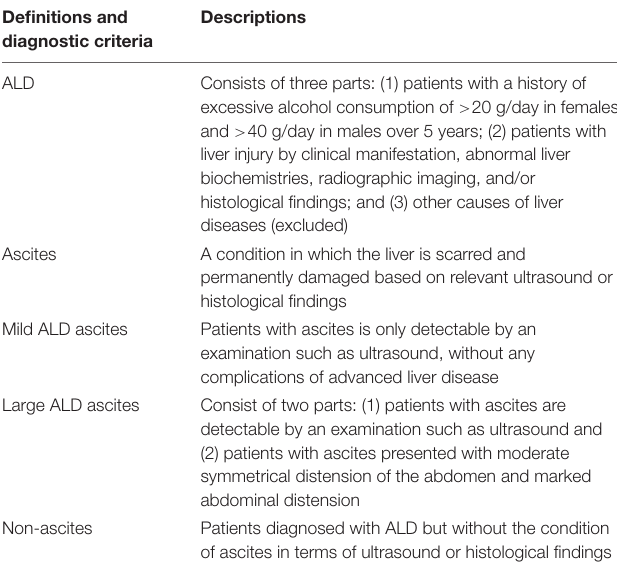
TABLE 1 | Diagnostic criteria and definitions of ALD with or without ascites